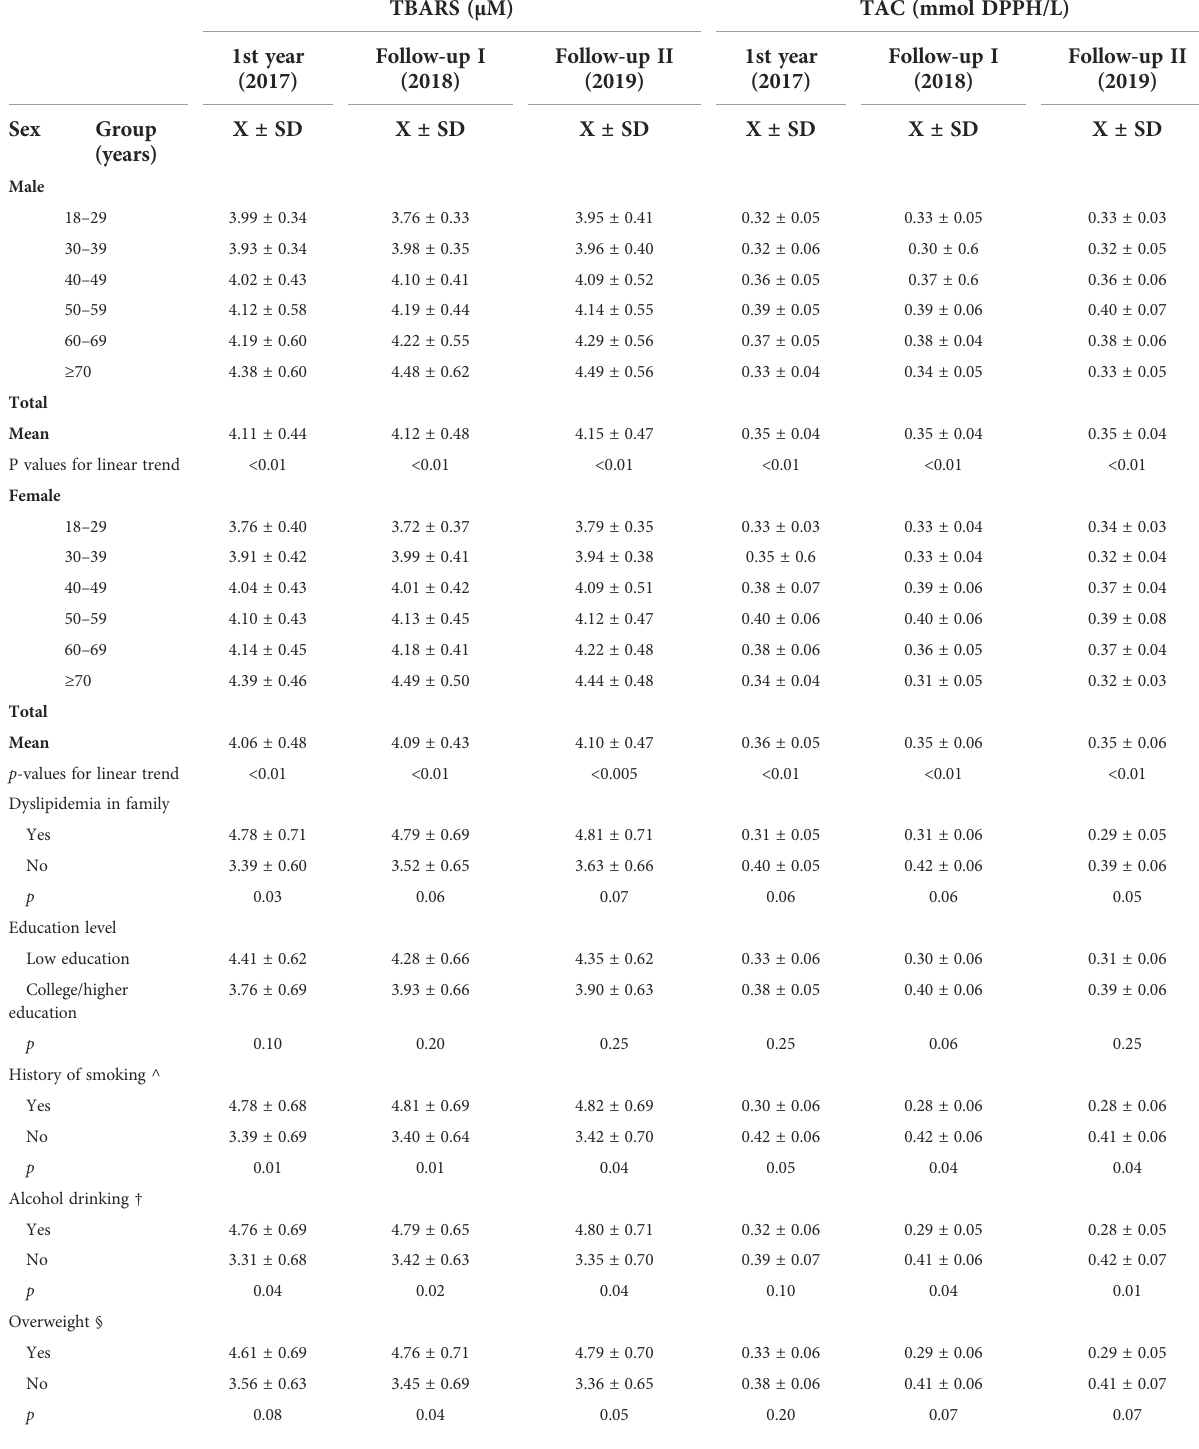
TABLE 6 The levels of serum oxidative status according to demographic and socioeconomic variables and familial history among adults in East Coast, Fujian, China in 2017 and 2-year follow-up. Serum oxidate